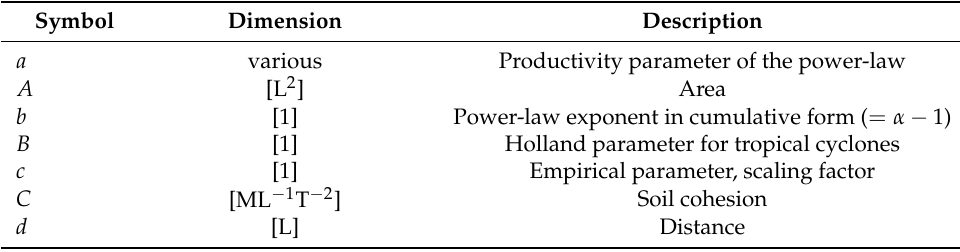
Table A1. List of symbols used in the present